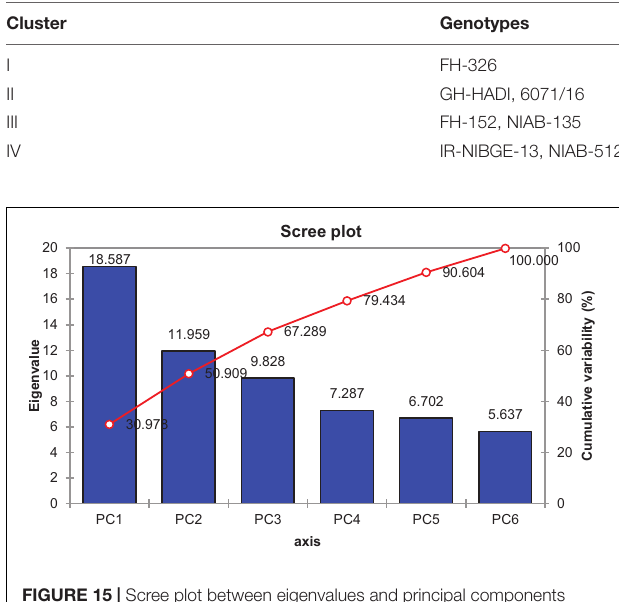
FIGURE 15 | Scree plot between eigenvalues and principal components (PCs) under control and salt stress conditions.